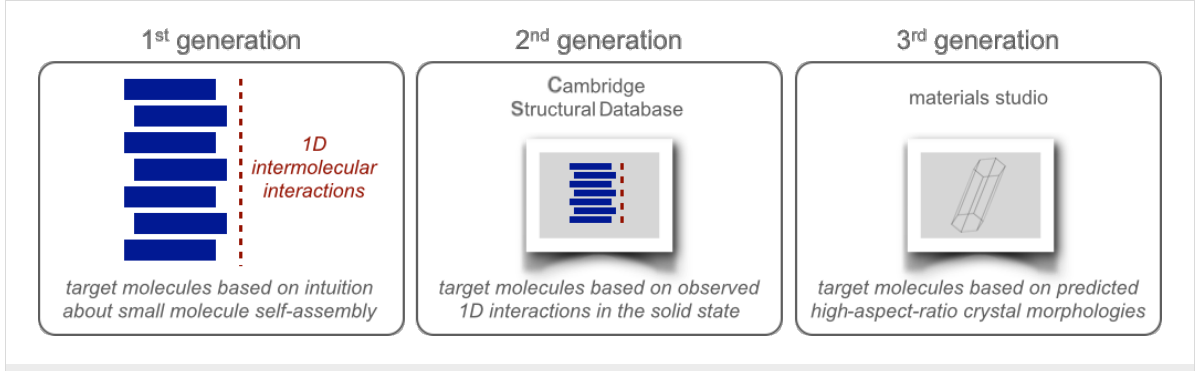
Figure 5: Evolution of our design strategy for identifying new gelators.